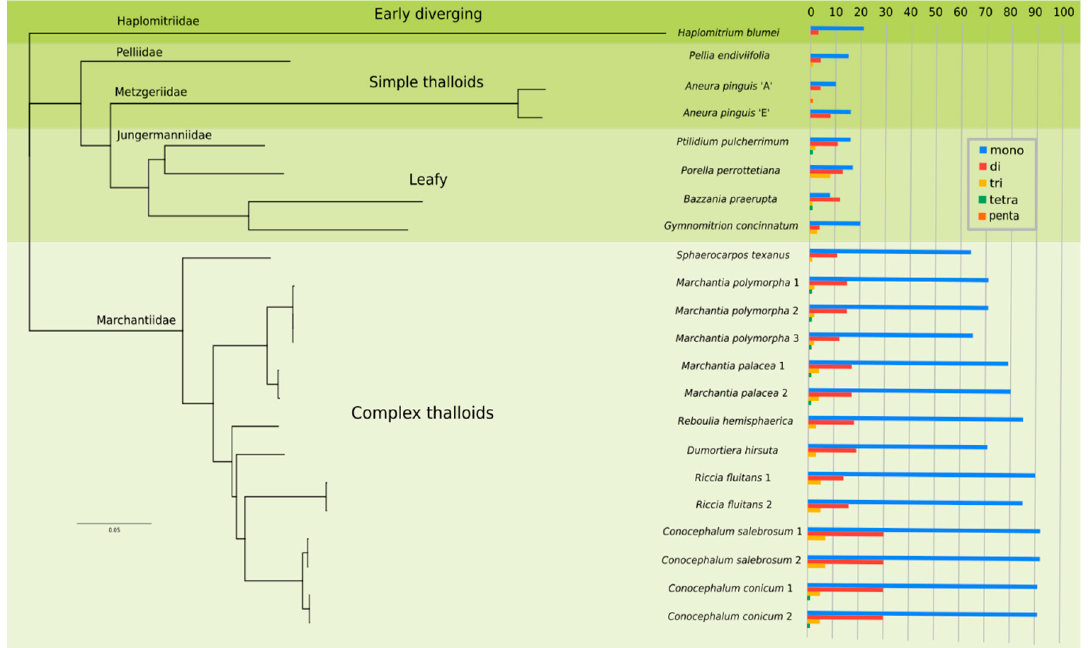
Figure 3. Phylogram based on coding regions of liverworts plastomes derived from a Bayesian analysis. The posterior probabilities values were equal to 1 for each of the clade. Right side of the figure provides data on SSR abundance in liverworts plastomes.